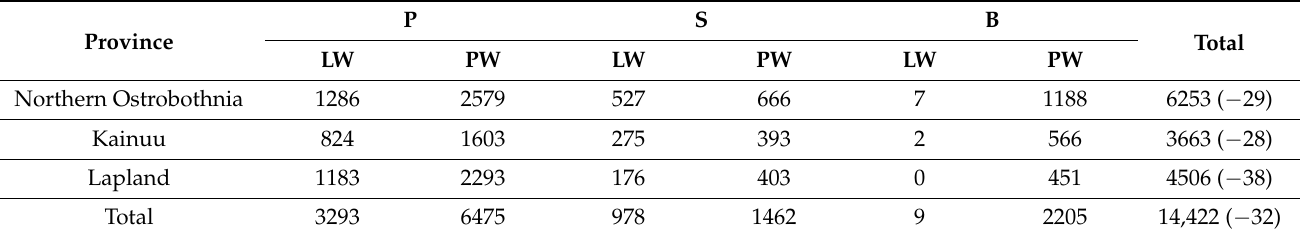
Table 1. Wood harvesting amounts in Northern Finland (1000 m 3 ) by province in 2018. P = Scotch pine ( Pinus sylvestris ), S = Norway spruce ( Picea abies (L.) H.Karst.), B = birch ( Betula pubescens Ehrh.), LW = logwood, and PW = pulpwood [28]. The percentage differences (%) between the maximum sustainable harvesting volumes and the realized volumes are in